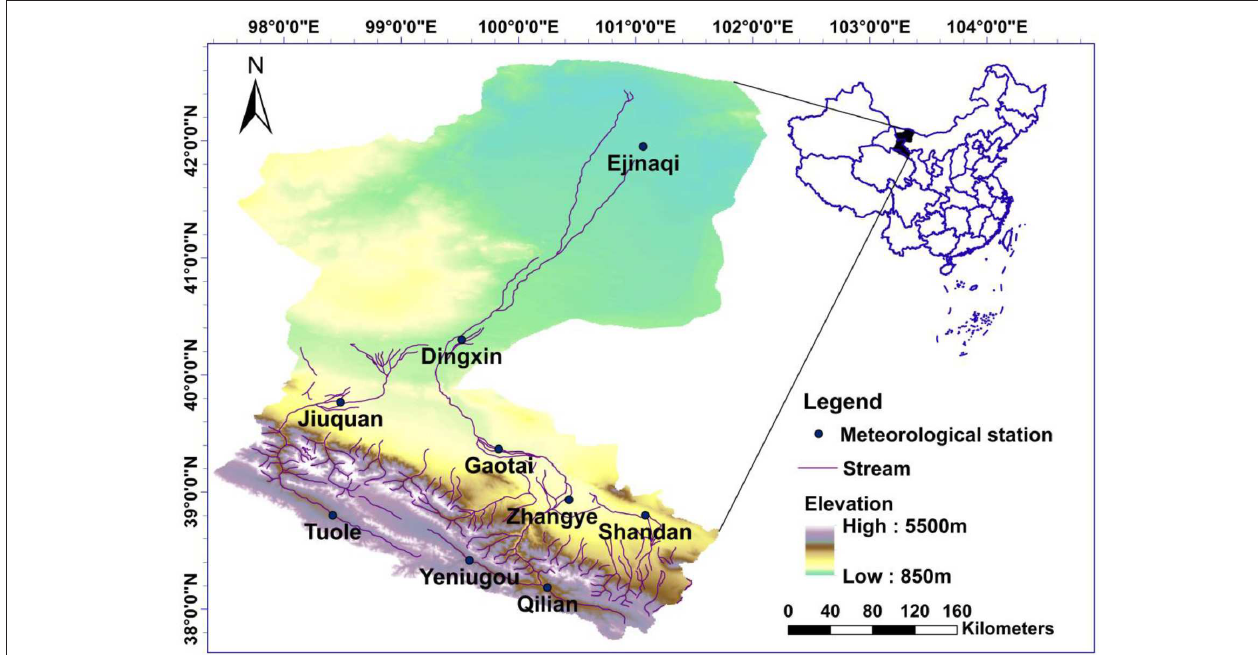
FIGURE 1 | Meteorological stations in Heihe River